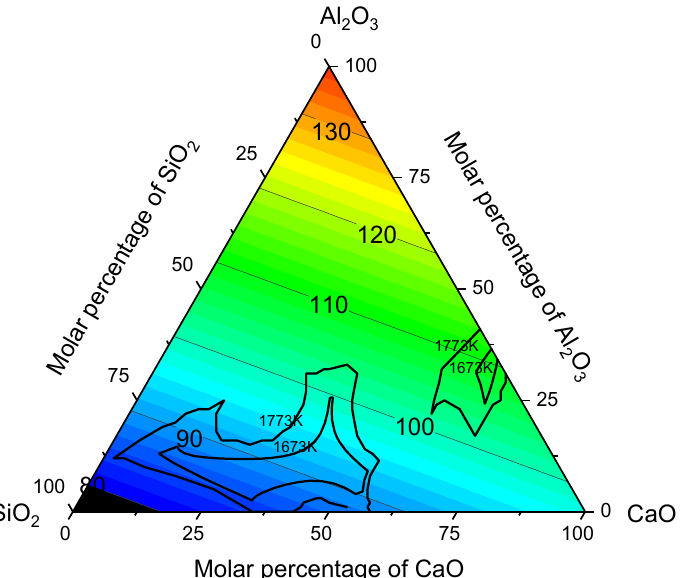
Figure 6. The liquid area at 1673–1773 K and iso-Young’s modulus (in GPa) diagram calculated from modified Appen’s equation for CaO-Al 2 O 3 -SiO 2 system.